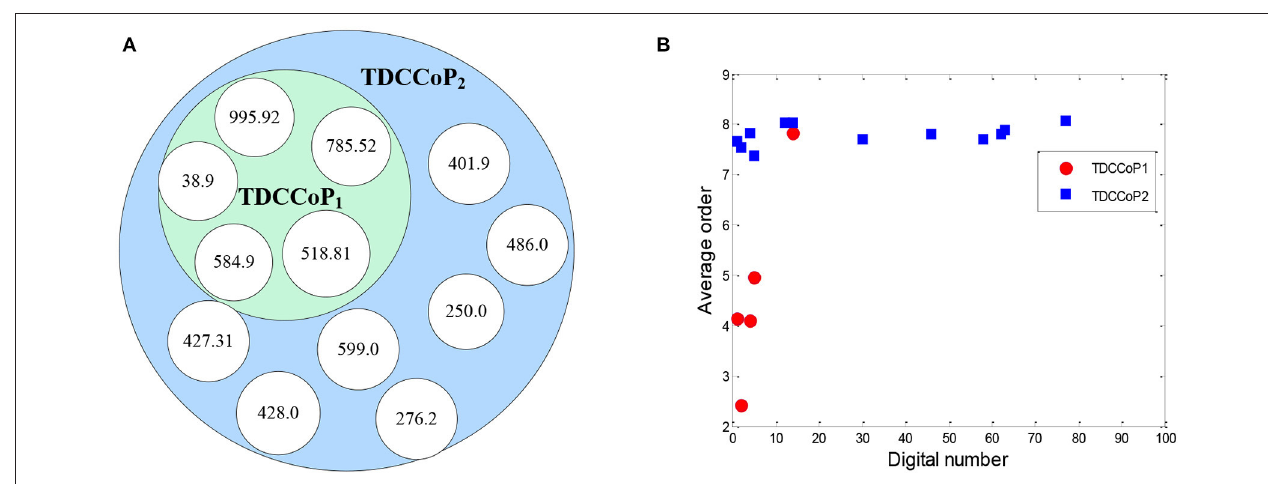
FIGURE 9 | Co-occurrence relation and AOrd of all TDCs. (A) Co-occurrence relation. (B) AOrd.